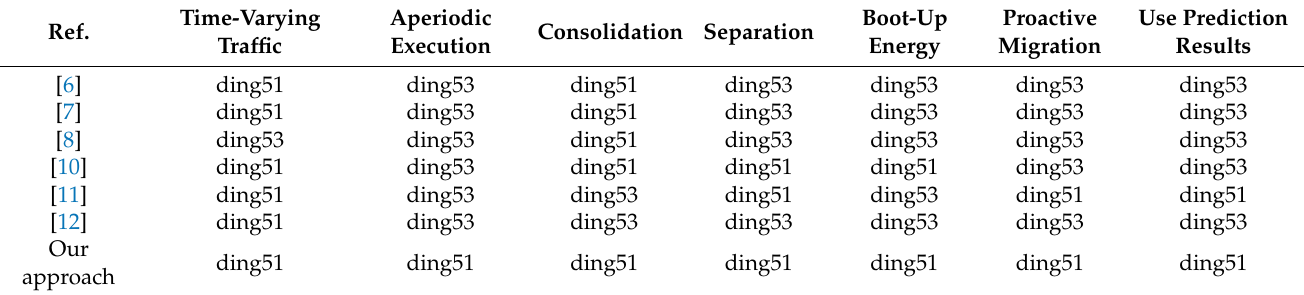
Table 1. Comparison of the research content of previous